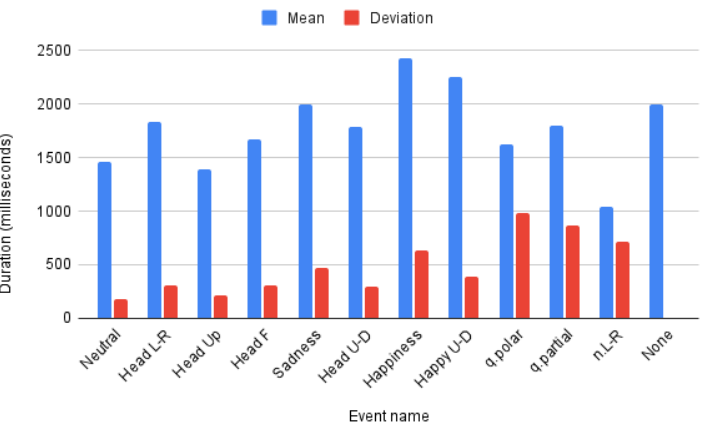
Figure 6. Duration per class in LSE_GFE and